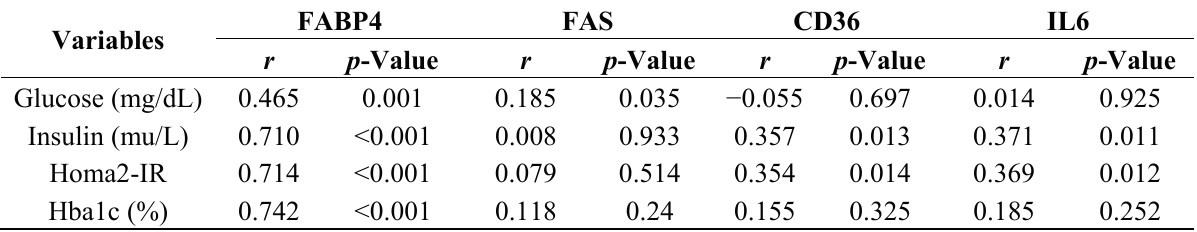
Table 4. Significant correlations between the expression of genes related to lipid metabolism and inflammation with glucose metabolism parameters in the morbidly obese